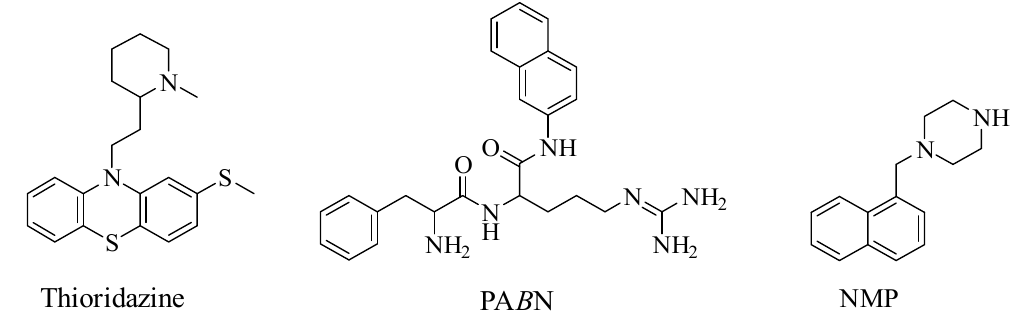
Figure 2. Chemical structures of the inhibitors used by Kvist et al [35].